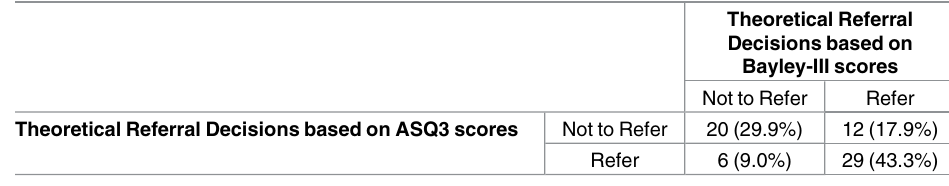
Table 4. Distribution of the theoretical referraldecisions based on the ASQ3 and Bayley-III